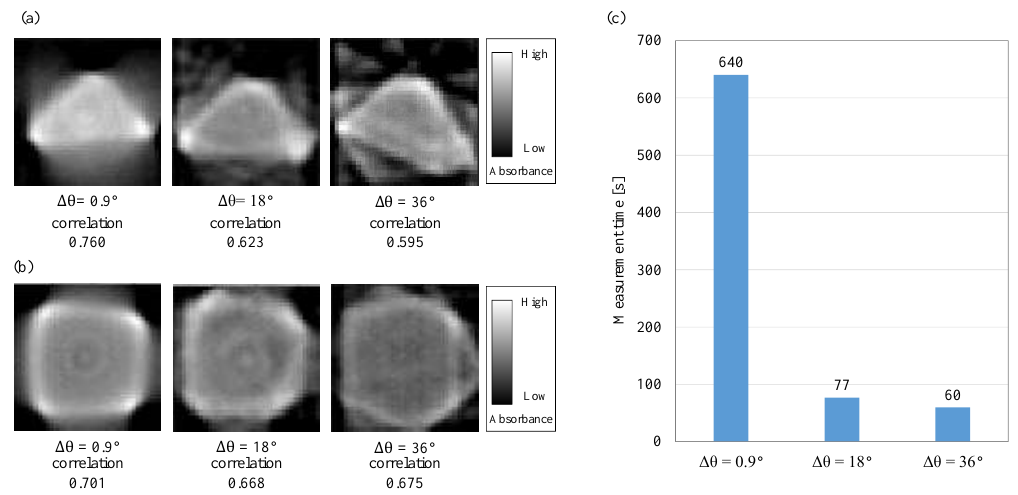
Figure A3. The outline when changing the resolution ∆ θ = 0.9 ◦ , 18 ◦ , and 36 ◦ . ( a ) A triangular prism; ( b ) a quadrangular prism and ( c ) the scanning time for recording.